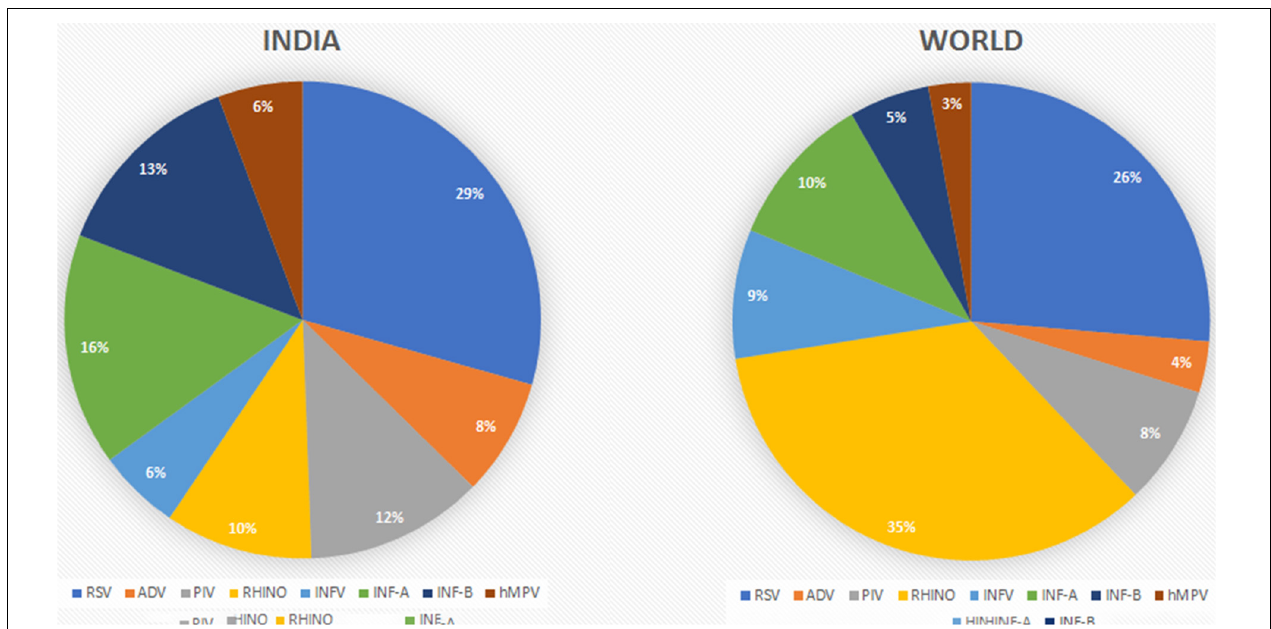
FIGURE 1 | Comparison of the prevalence rates of viral infections between India and the rest of the